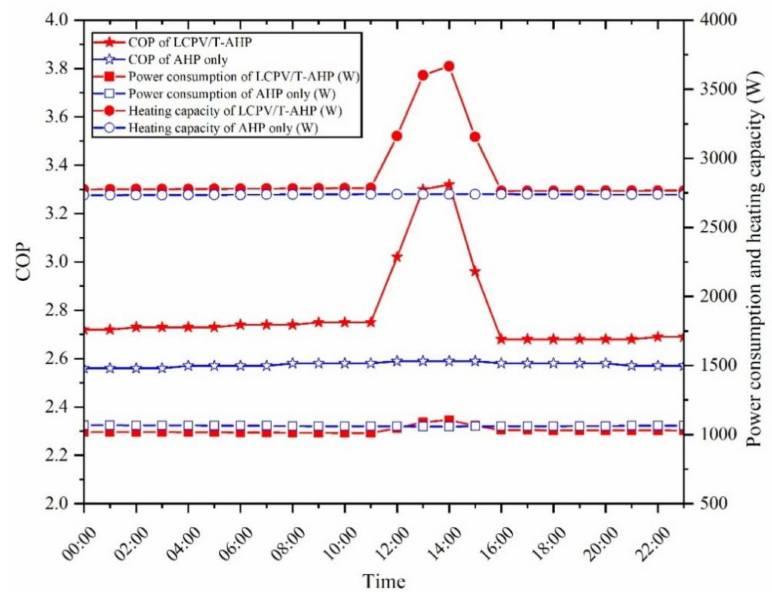
Figure 16. AHP performance comparison between the LCPV/T-AHP system and AHP only system on 15